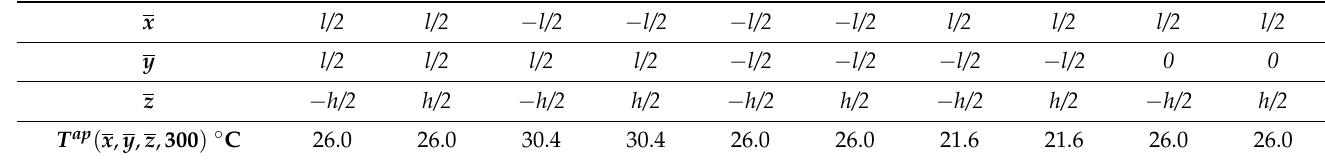
Table 6. Temperatures in the corners of the copper plate and at the midpoint of the plate’s surface facing the inlet of heated air to the room for T c = 31 ◦ C, v a = 4.5 m/s, and t = 300